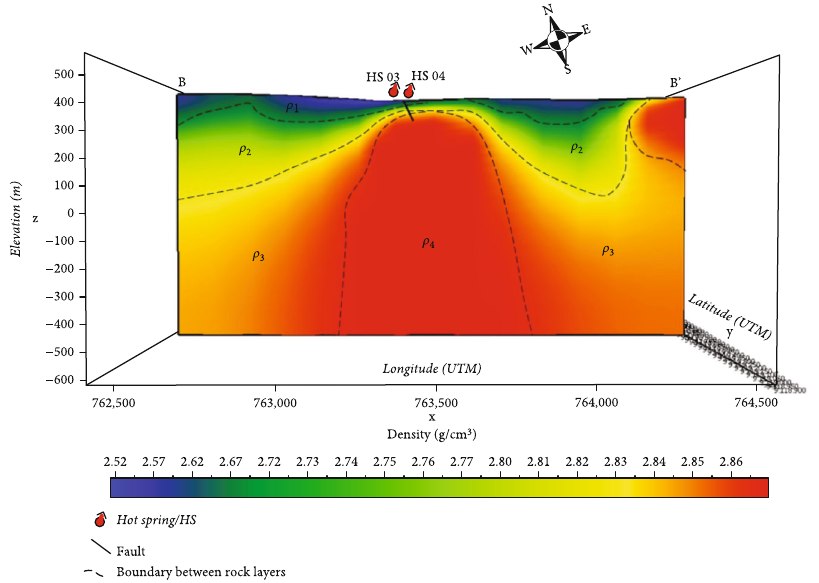
Figure 15: Cross-section of the B-B ” incision on the body of the 3D inversion